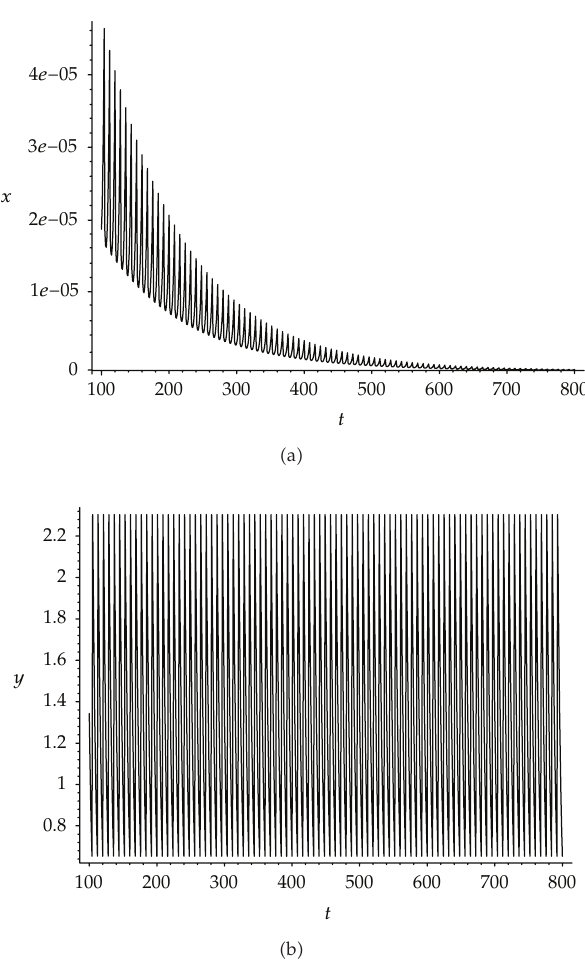
Figure 1: Dynamic behavior of system (cid:2) 1.1 (cid:3) . When T < T max ≈ 9, the algae will be eradicated. Time series evolving according to biological control system (cid:2) 1.1 (cid:3) of (cid:2) a (cid:3) the algae population x , (cid:2) b (cid:3) the fish population y